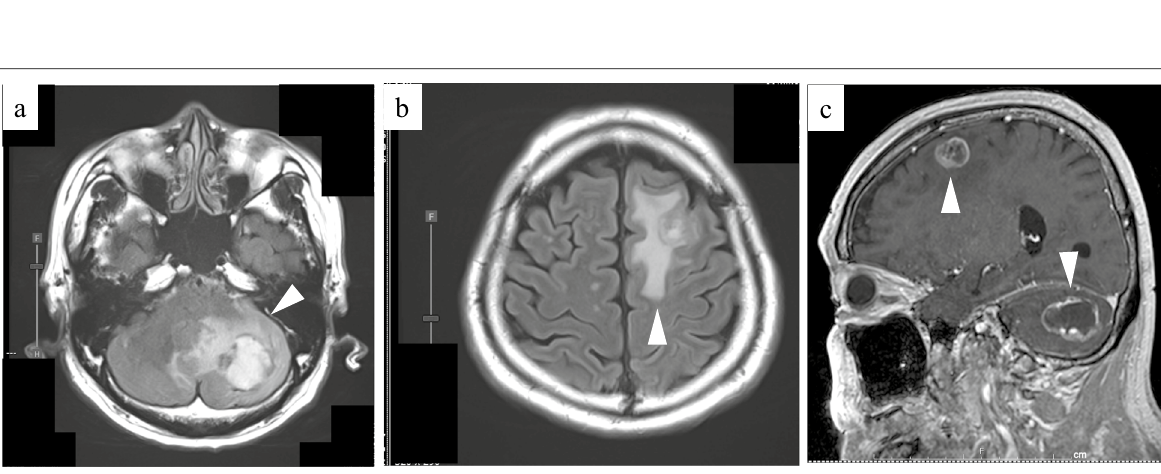
Fig. 3 Enhanced magnetic resonance imaging of head. a T2-weighted image: A left cerebellar hemisphere mass with extensive surrounding edema is present. b T2-weighted image: A left frontal lobe mass with extensive surrounding edema is present. c T1-weighted image: The tumor has a contrast effect on the margins and is suspected to be brain